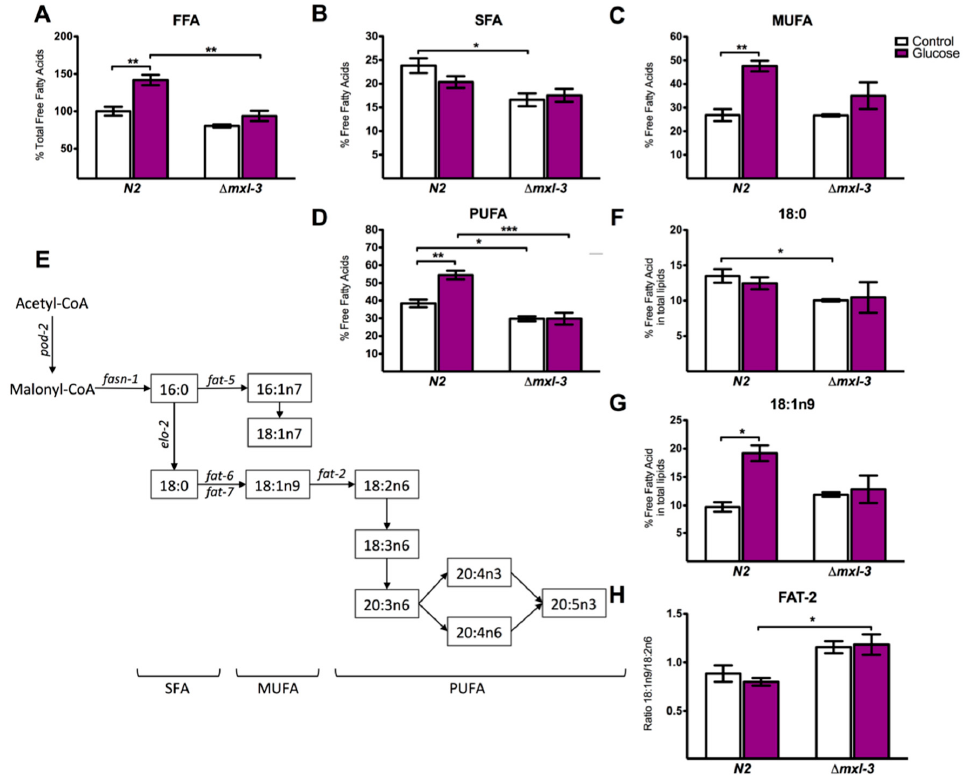
Figure 4. MXL-3 participates in the regulation of fatty acid synthesis, elongation and desaturation. Fat content changed markedly in worms exposed to glucose. ( A – D ) N2 worms administered glucose demonstrated augmented FFAs, MUFAs, and PUFAs, whereas these FAs were decreased in the mxl-3 mutant, even under high-glucose conditions. In contrast, SFA decreased under the same conditions. ( E ) Schematic representation of the SFA, MUFA, and PUFA synthesis pathways. ( F ) 18:0 (stearic acid) was decreased and ( G ) 18:1n9 (oleic acid) was augmented. These responses were absent in the mxl-3 mutant strain. ( H ) FAT-2 activity was indirectly measured from substrate/product ratios. If the relationship increased, a decrease in activity was inferred. Each graph shows the mean ± SEM of three independent experiments; * p < 0.05, ** p < 0.01, *** p < 0.001, one-way ANOVA with Bonferroni’s post hoc test using GraphPad